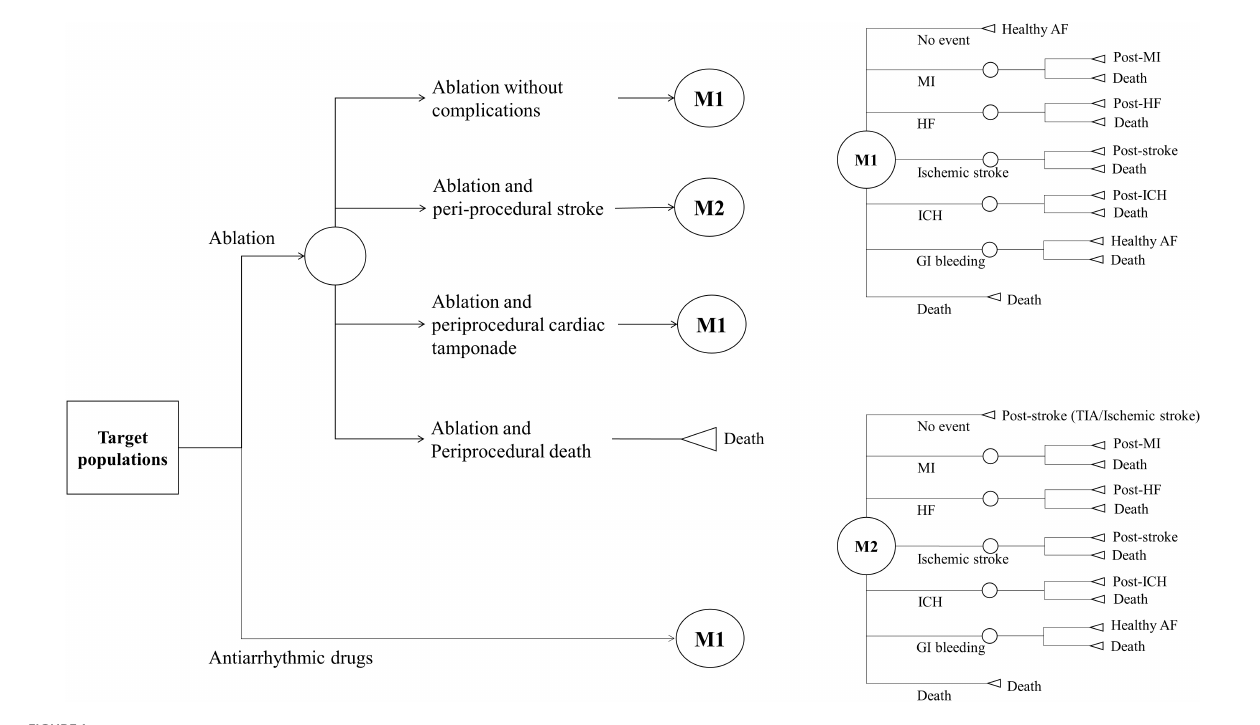
FIGURE1 Markov model for decision